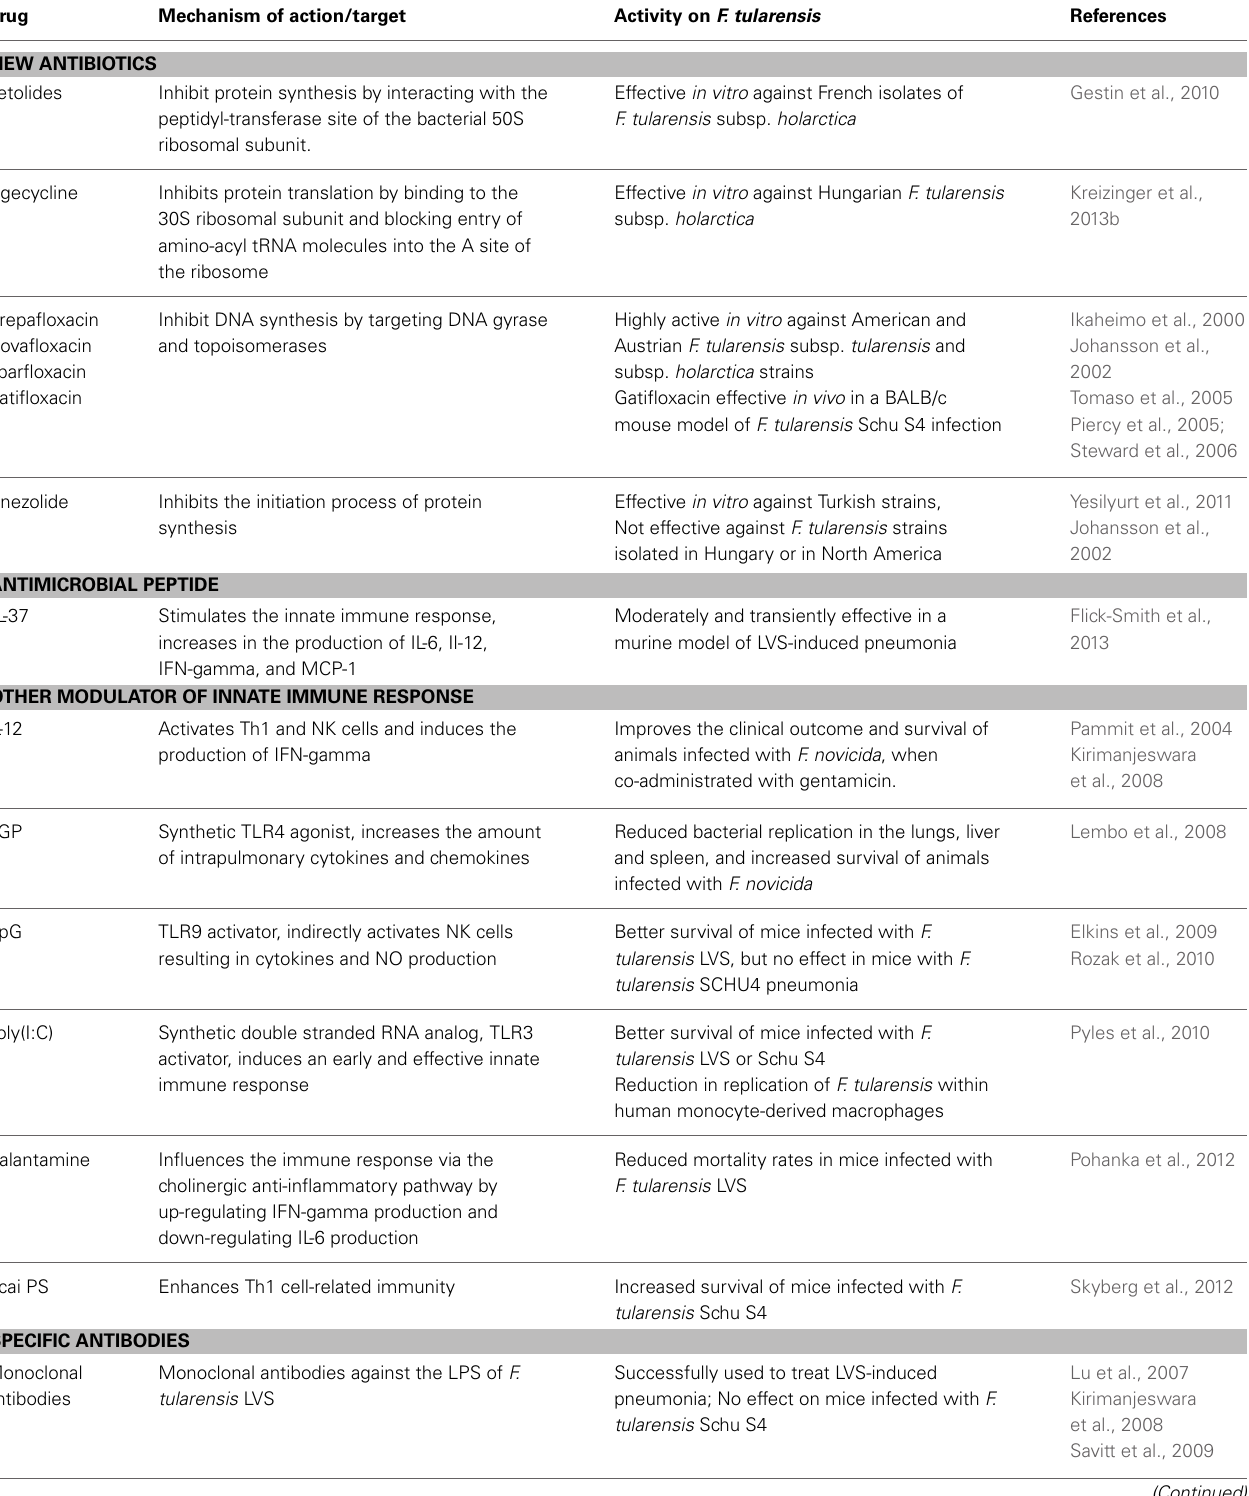
Table 1 | New therapeutic alternatives evaluated against F. tularensis